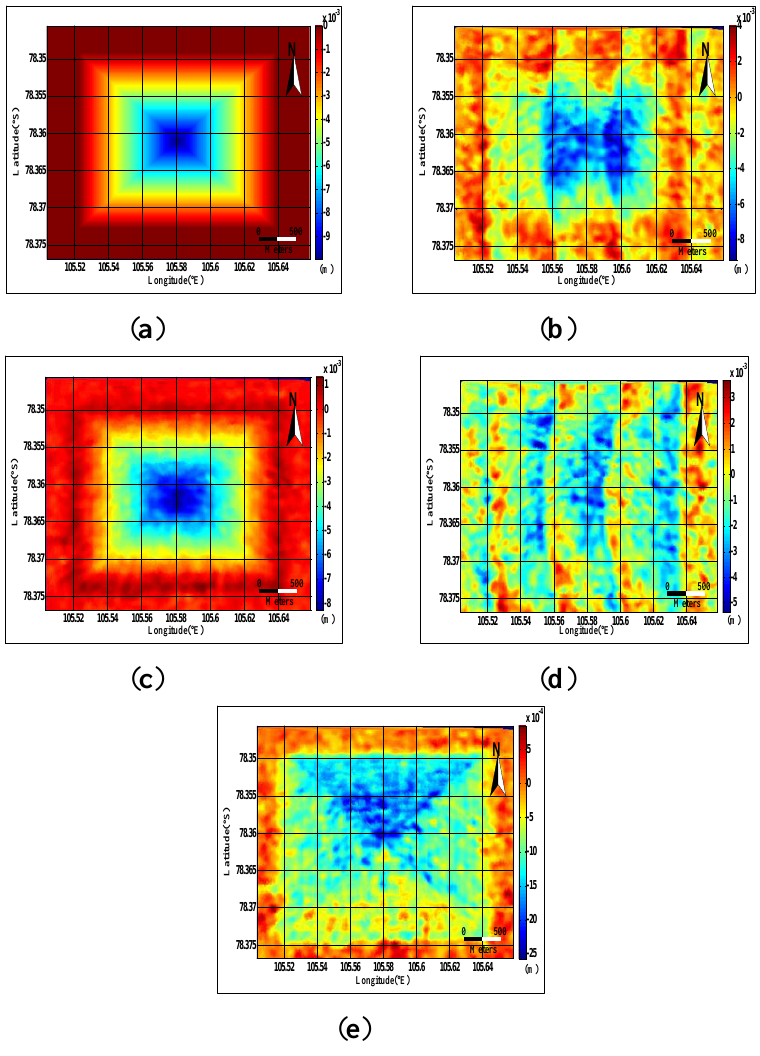
Figure 8. ( a ) Reference deformation map; ( b ) obtained deformation map (ZDC data acquisition method); ( c ) obtained deformation map (OMRD data acquisition method); ( d ) deformation error map (ZDC data acquisition method) (root mean square error (RMSE) = 0.0016 m); ( e ) deformation error map (OMRD data acquisition method) (RMSE = 0.0009